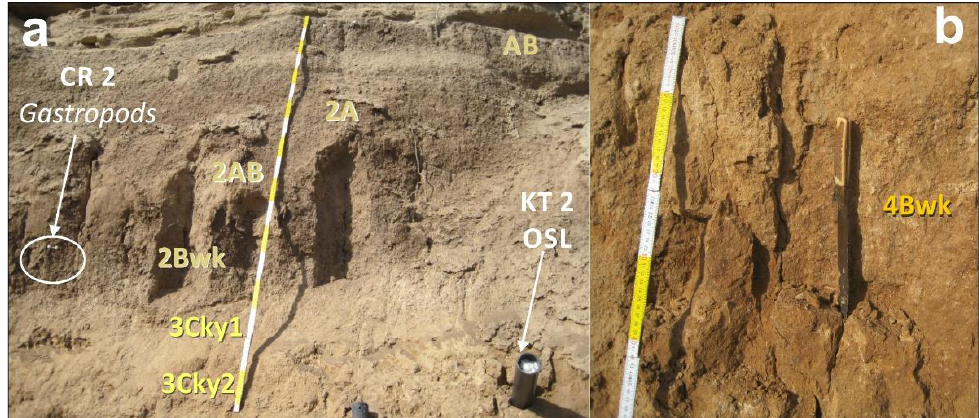
Figure 6. Pedogenic morphological features of ( a ) the Roman period paleosol Cycle 2 and ( b ) the Bronze Age paleosol of Cycle 4. Note ( a ) the incipient blocky structure in the horizon 2Bwk and ( b ) more developed prismatic structure in the horizon 4Bwk.